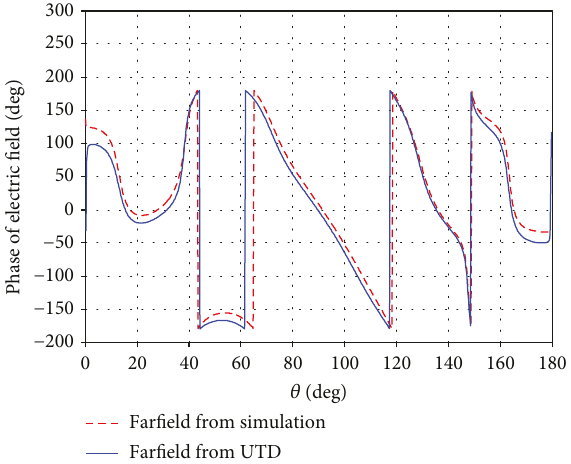
Figure 5: Total fi eld and double-di ff racted fi eld in the ϕ =20 ° plane with w =4 λ and h =1 λ , at 4 GHz.